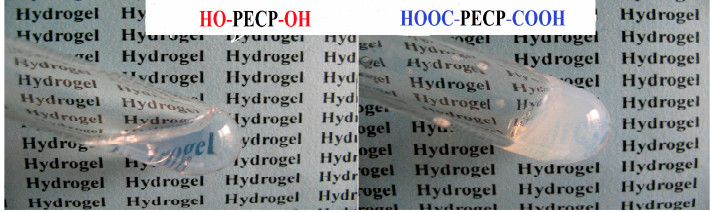
Figure 4. Hydroxyl terminated PECP sol solution (25 wt %) and carboxylic terminated PECP gel state (25 wt %) visualized at 30 °C.